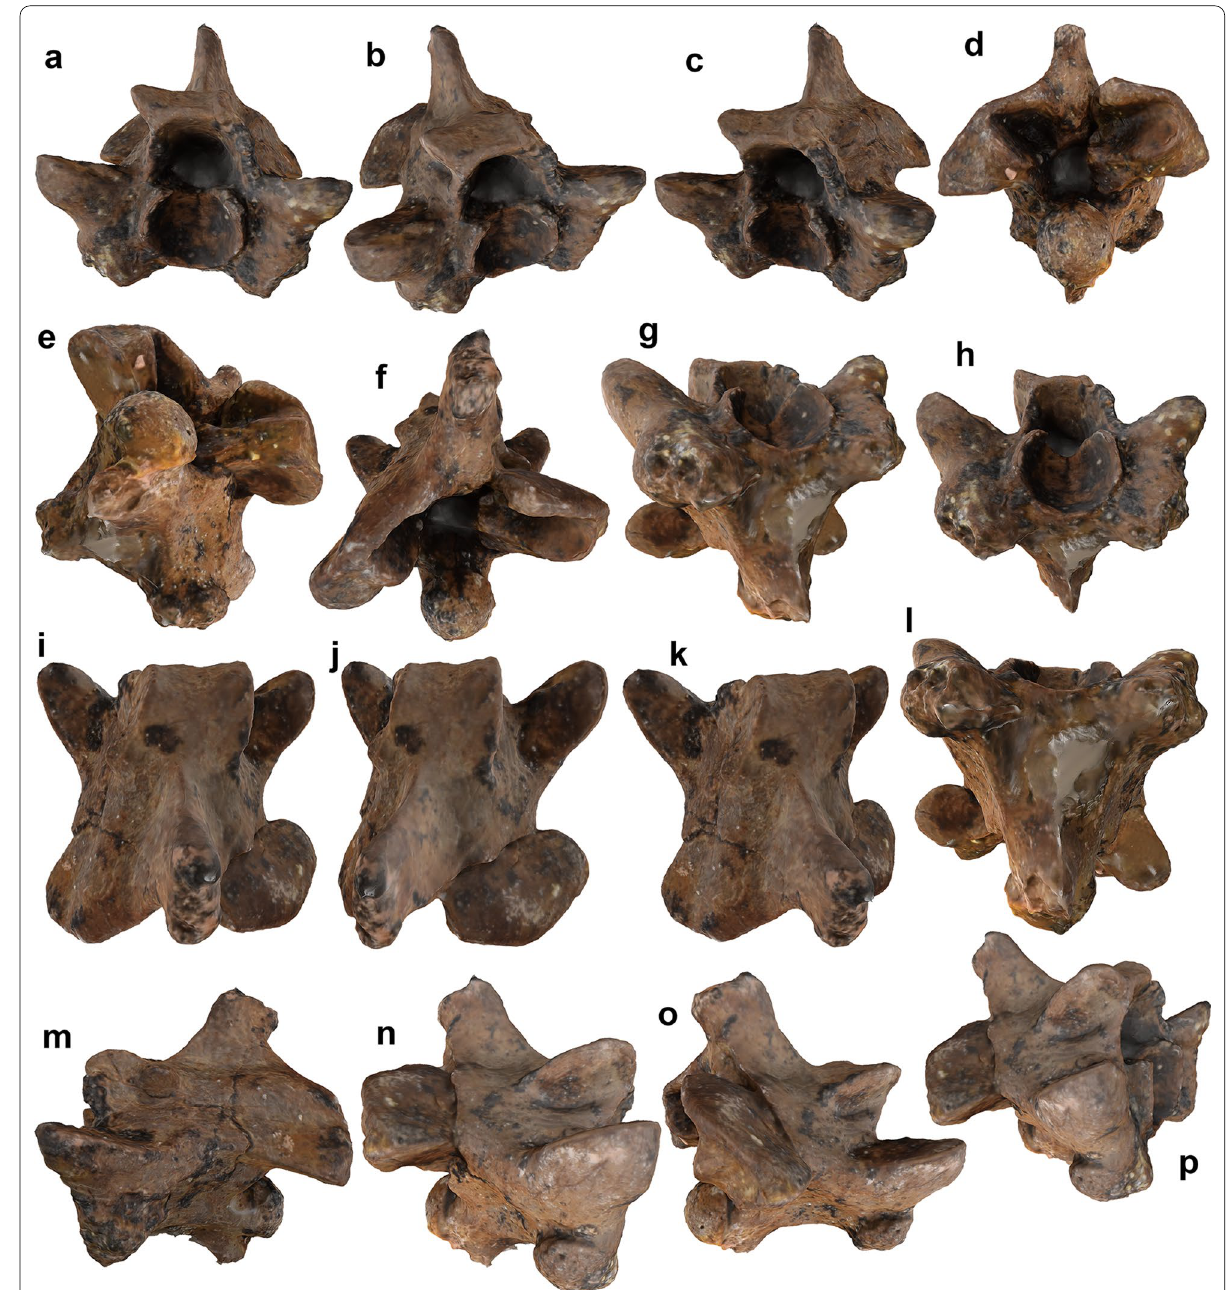
Fig. 74 Eoconstrictor spinifer comb. nov. from quarry Cecilie I, Geiseltal—paralectotype (GMH Ce I-5822-1926), part: 3D models of (the most complete) anterior trunk in anterior ( a ), anterodorsal ( b , c ), posterior ( d ), posteroventral ( e ), posterodorsal ( f ), anteroventral ( g , h ), dorsal ( i ), dorsolateral ( j , k ), ventral ( l ), left lateral ( m ), right lateral ( n ), posterolateral ( o ), and anterolateral ( p ) views. Images only at approximately the